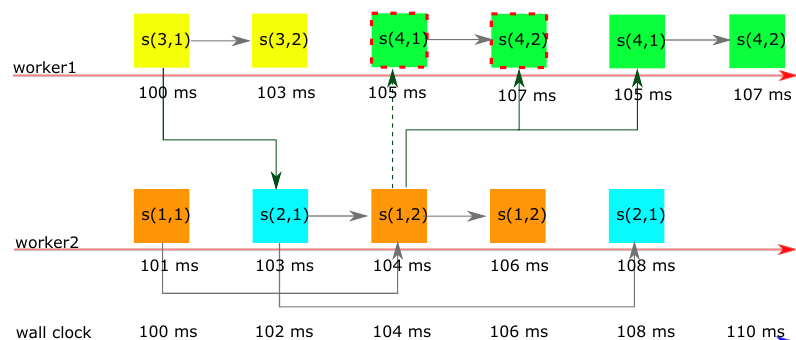
Figure 7. Typical scenario of an optimistic synchronised simulator.